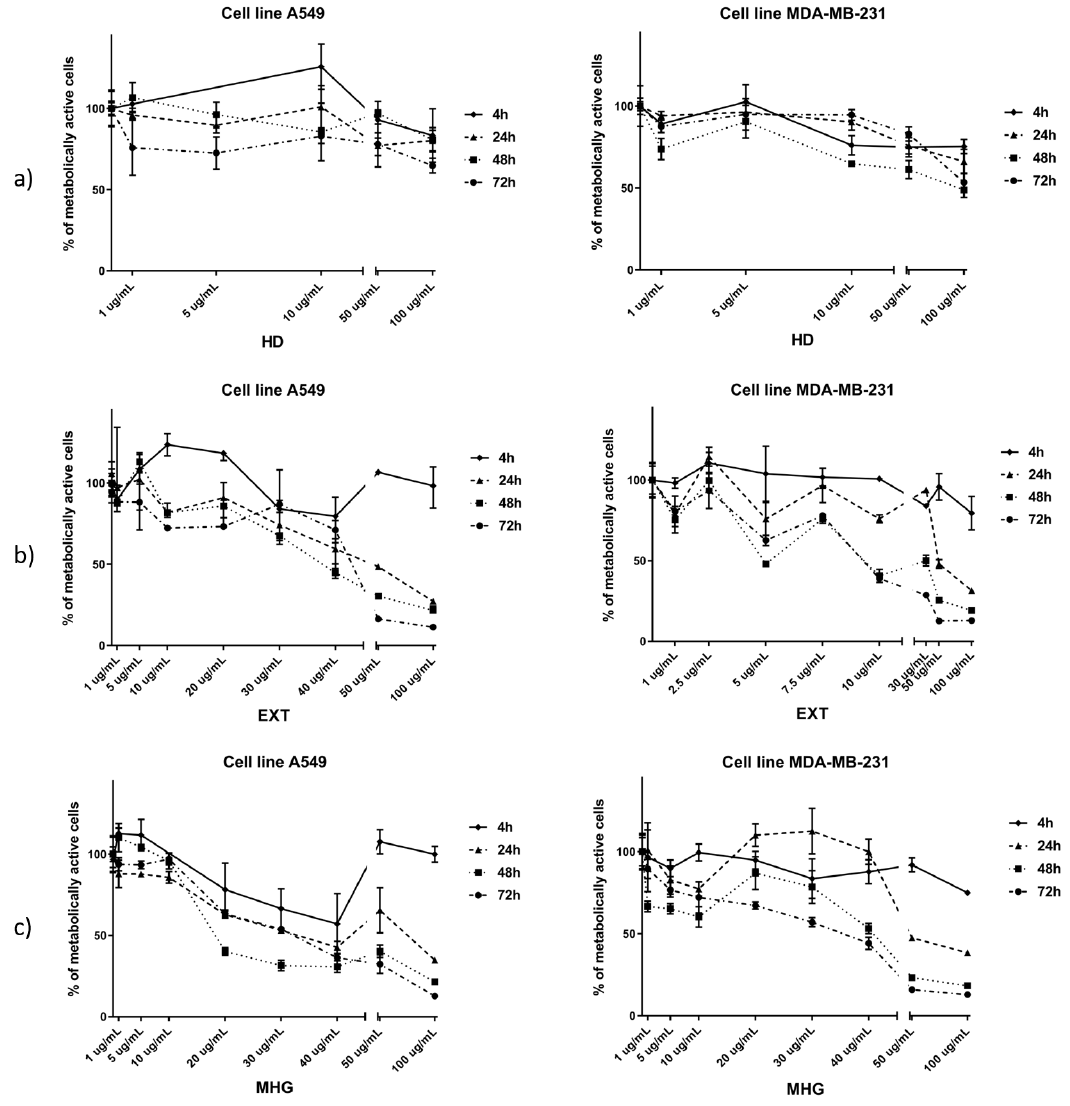
Figure 4. Percentage of metabolically active human lung cancer cell line A549 and breast cancer cell line MDA-MB-231 after 4, 24, 48, and 72 h of incubation with di ff erent concentrations of: ( a ) hydrodistillate in Clevenger type apparatus (HD), ( b ) CH 2 Cl 2 extraction after 24 h of autolysis and added myrosinase (EXT), and ( c ) microwave hydrodi ff usion and gravity (MHG). Calculated IC 50 values ( µ g / mL) are given in Table S1.